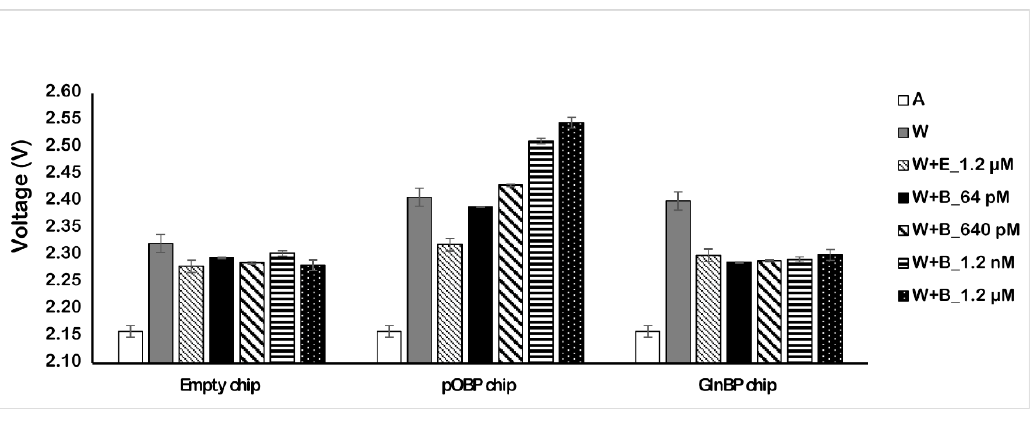
Figure 3. Sensor measurements in solution. Variation of the voltage in the absence (dry, water, and ethanol) and in the presence of different concentrations of benzene (64 pM and 1.2 µM) by using the 200 µm sensor chip. Table 1. Variation of the voltage of 200 µ m interdigitated sensor chip in three different